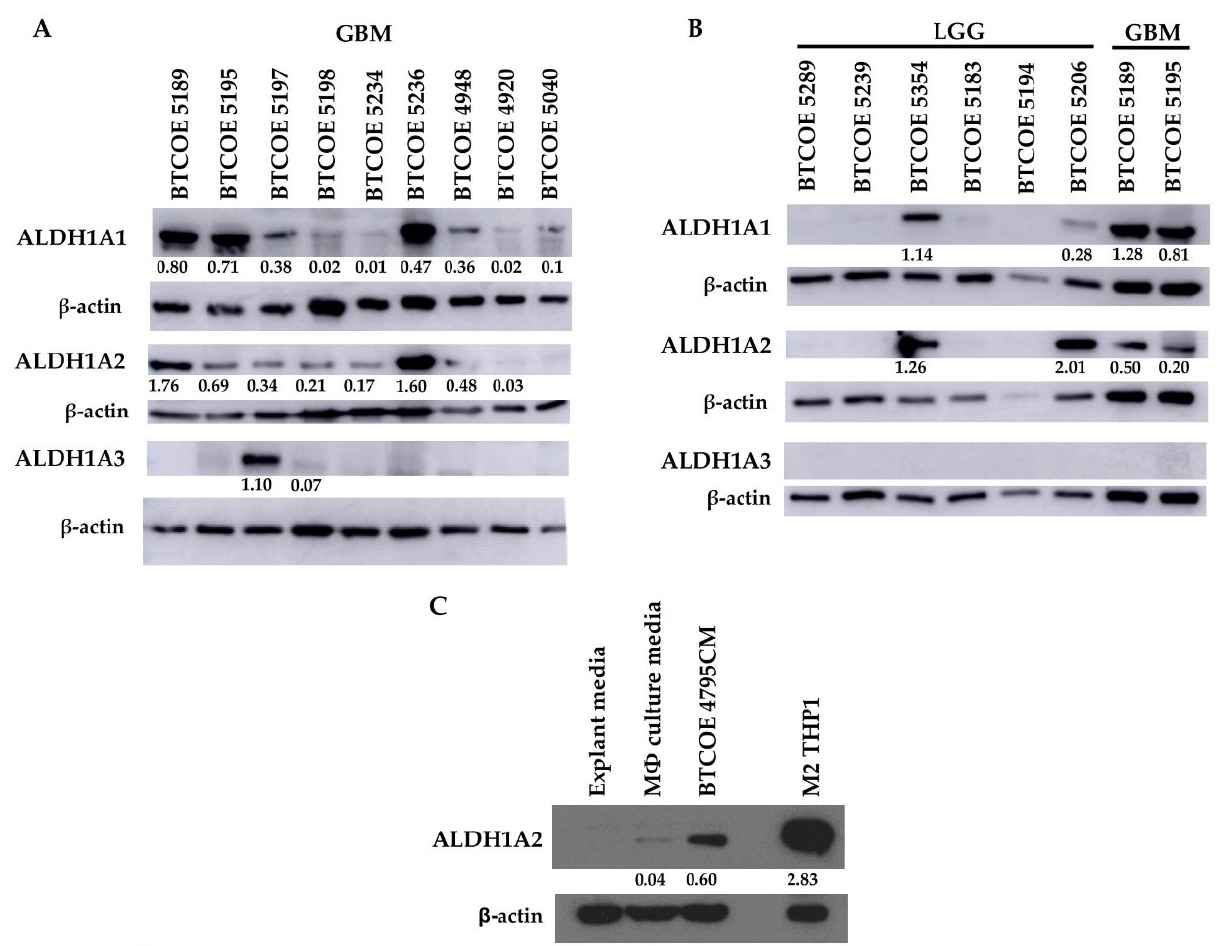
Figure 4. ALDH1A2 is expressed at higher levels in GBM compared to LGG and other common ALDH1 family proteins. Expression of ALDH1A1, ALDH1A2, and ALDH1A3 in ( A ) GBM patient samples (representative of at least 2 blots), and ( B ) low-grade glioma (LGG) (representative of 5 blots). ( C ) GBM cell-conditioned media is sufficient to induce ALDH1A2 expression in the THP1 monocytic cell model (representative of 2 blots).